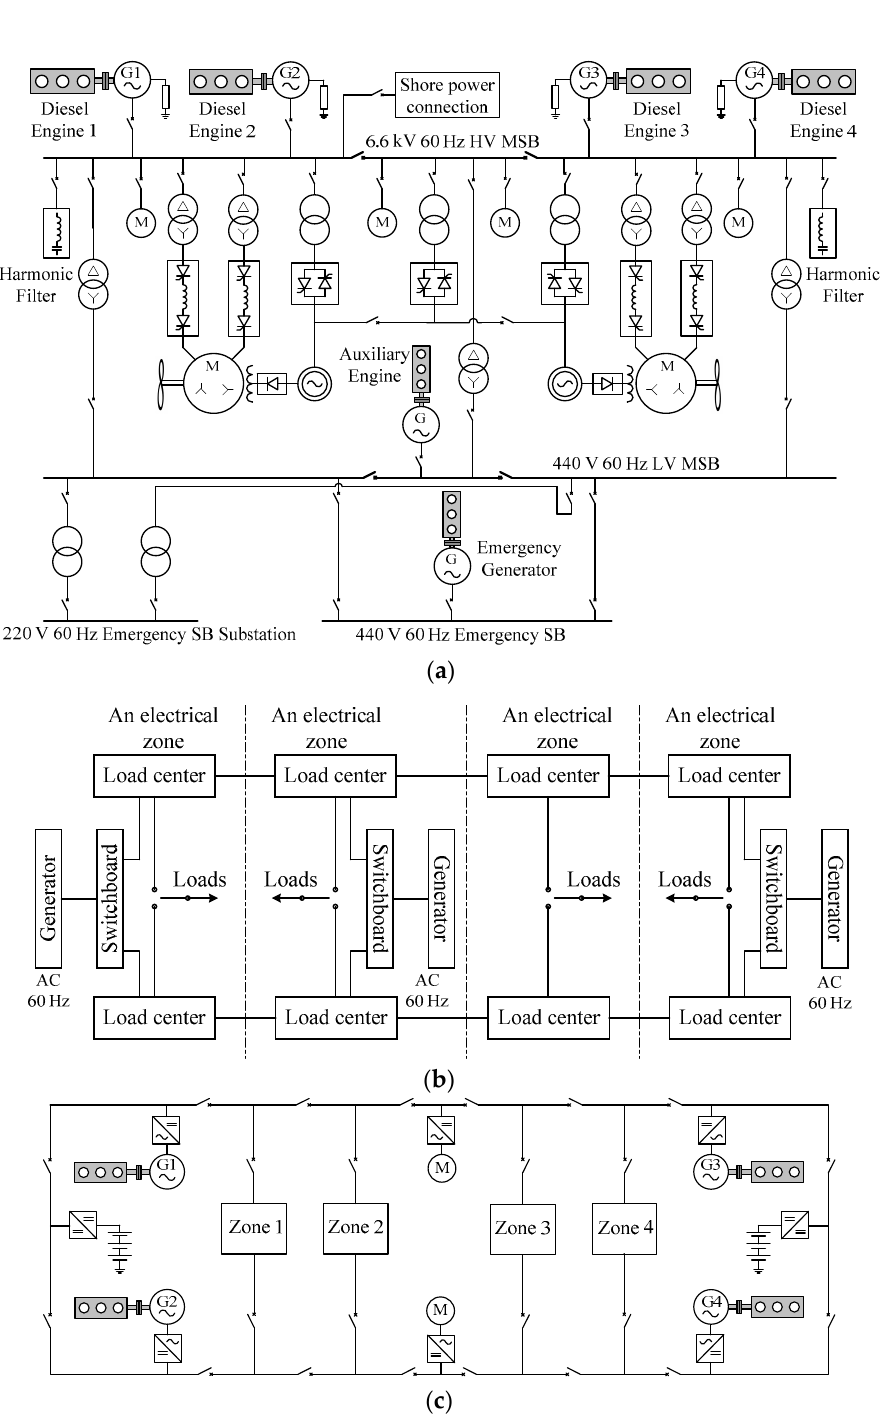
Figure 1. ( a ) High voltage/low voltage (HV/LV) Shipboard radial power system; ( b ) AC zonal electrical distribution system (ACZEDS); ( c ) DC zonal electrical distribution system (DCZEDS).